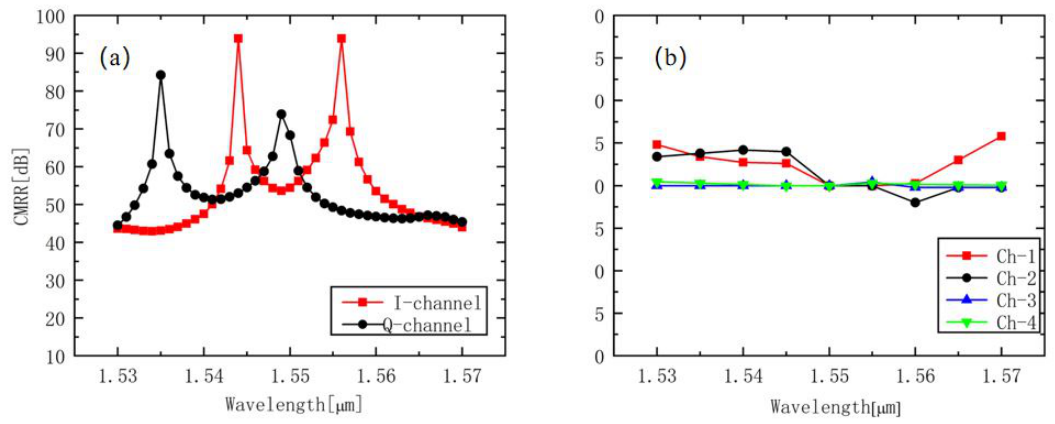
Figure 4. Simulated ( a ) CMRR and ( b ) phase error of the 90° hybrid when the thickness of the core layer is reduced by 0.1μm.